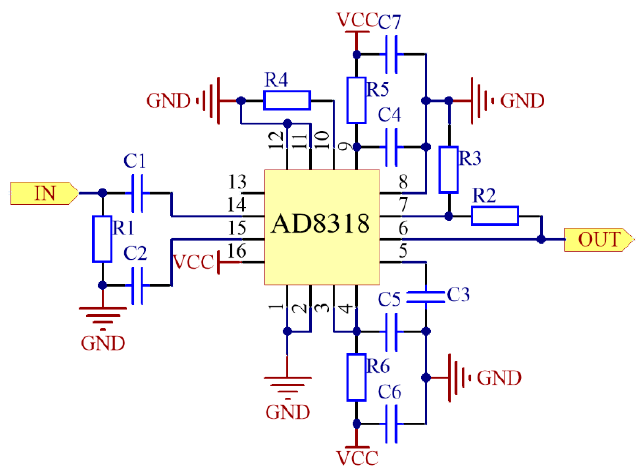
Figure 3. Schematic diagram of power detection module.